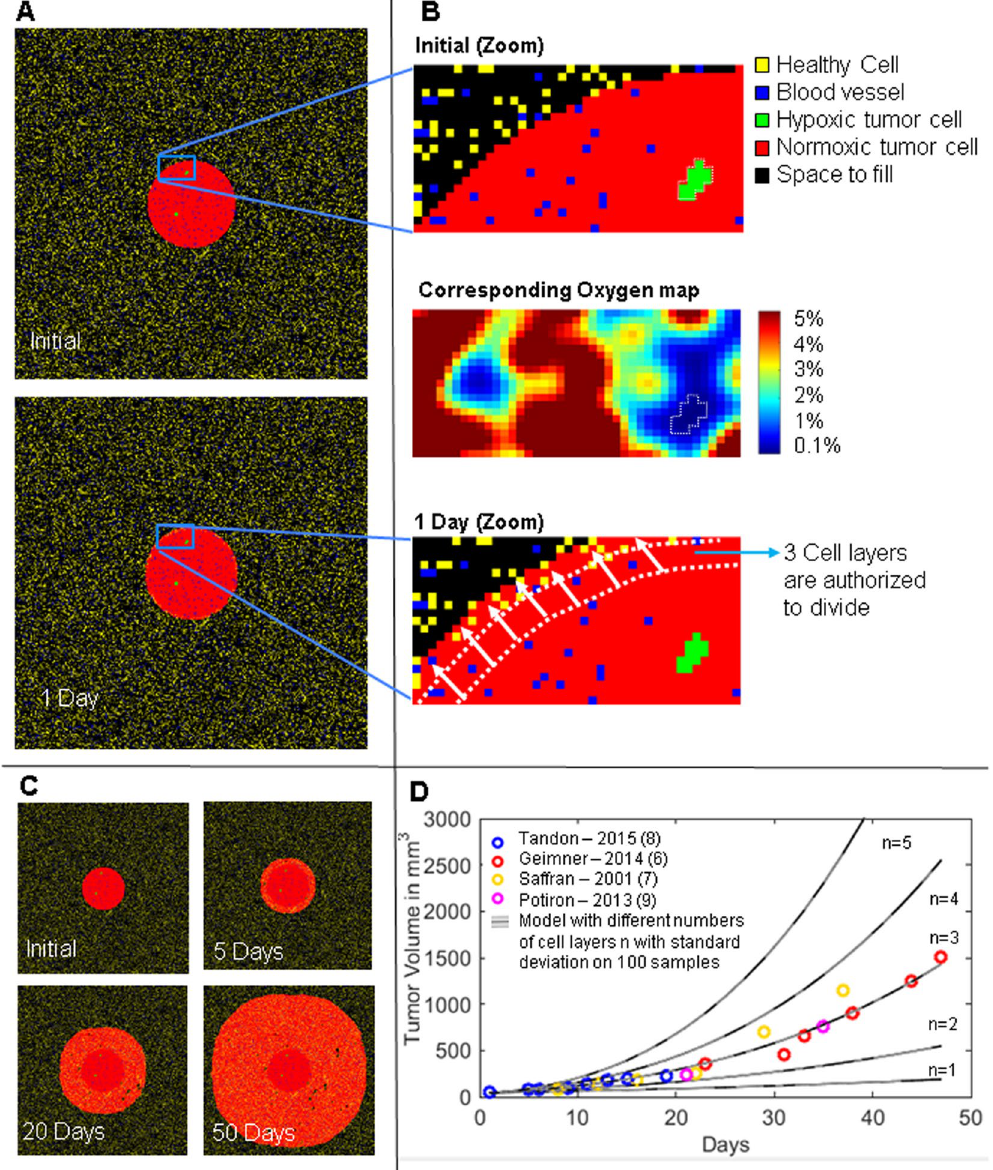
Figure 1. Tumour Growth Model. ( A ) Automata model of the tumour at day 0 and 1 day later, i.e. one cell cycle later. ( B ) Each pixel corresponds to a tumour and endothelial cell state. Endothelial distribution, i.e. vessel network, allows computation of an O2 ratio in the tumour map. ( C) Tumour growth simulation without irradiation. ( D ) Calibration of the number of cell layers authorized to divide at the tumour periphery based on growth data obtained from the literature for PC3 tumours in mice. Setting cell layers to 3 gives the best fit for these data (i.e. n =